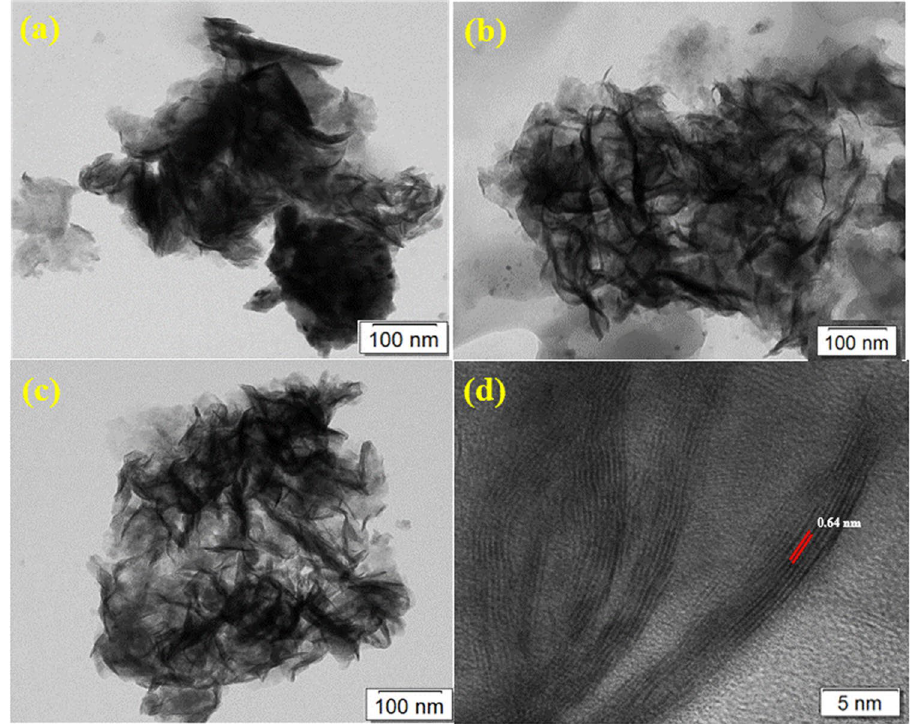
Figure 3. ( a – c ) HR-TEM images of MoSe 2 nanosheets and ( d ) the lattice fringe corresponding to the d spacing of MoSe 2